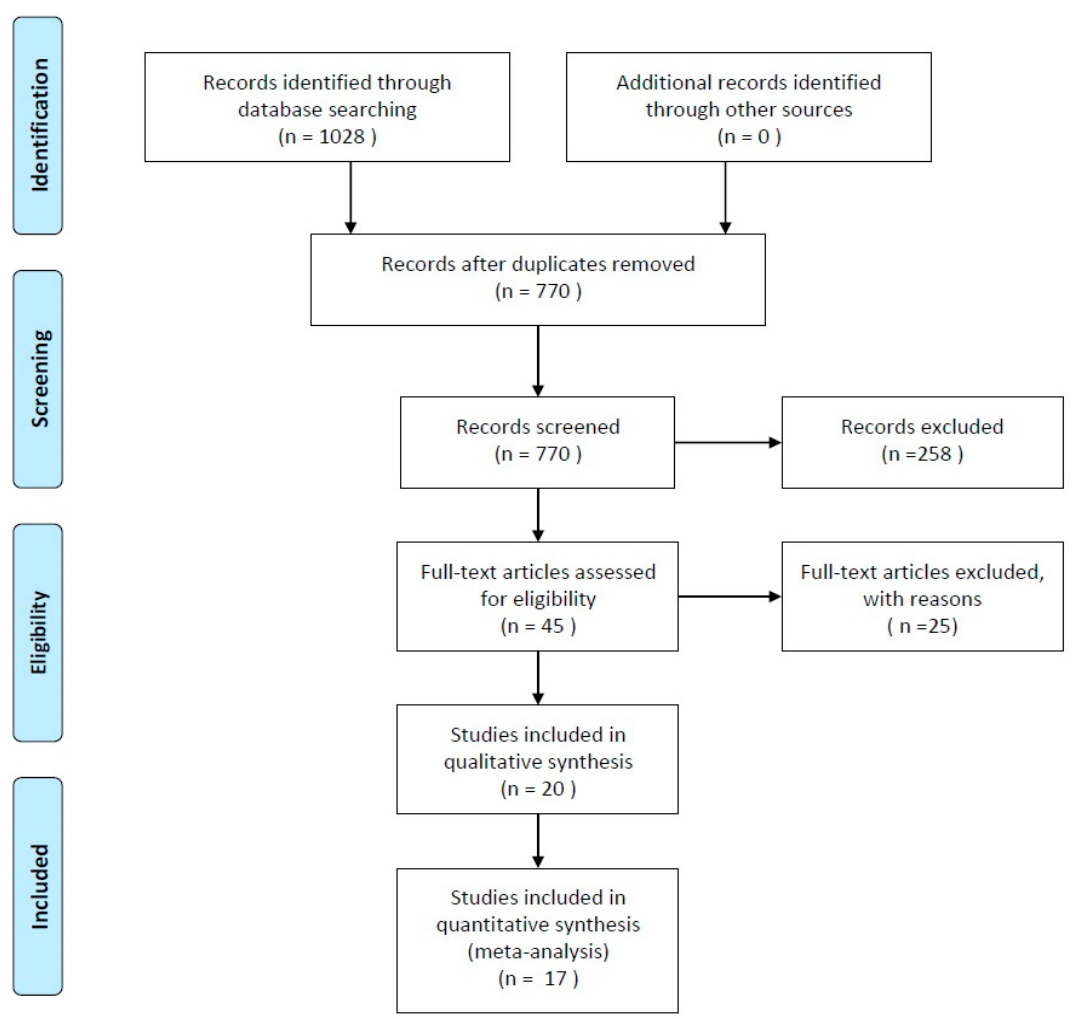
Figure 1. Flow chart diagram (2009) of search strategy adapted from PRISMA.